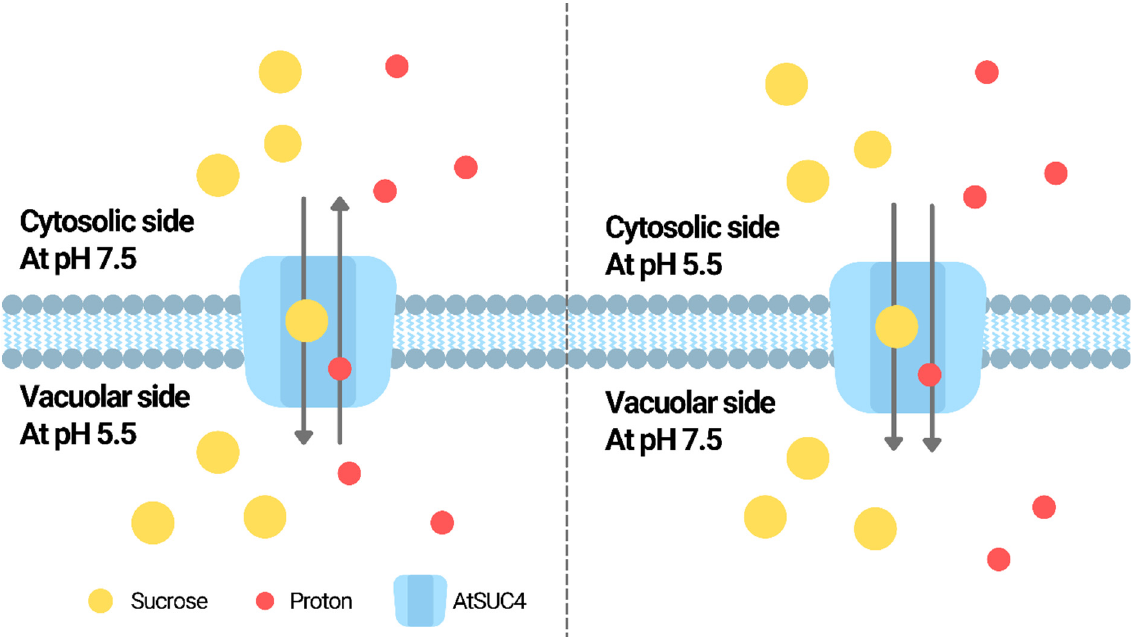
Figure 1. The switch of antiporter/symporter activity of AtSUC4. When the vacuole lumen was more acidic than the medium outside, AtSUC4 mediates the import of sucrose into the vacuole with the export of H + from the vacuole; when the medium outside the vacuole was more acidic, AtSUC4 mediates the transport of sucrose together with proton into the vacuole [78].